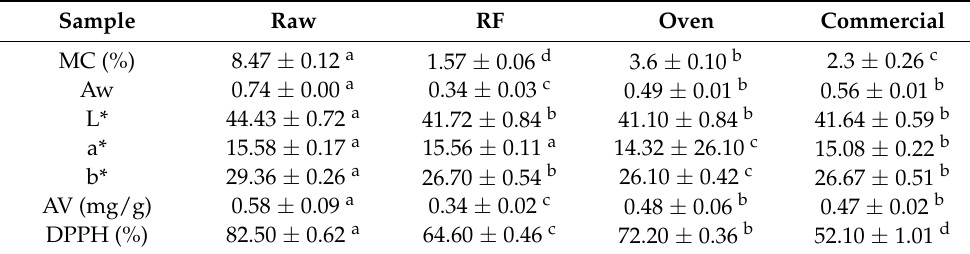
Table 1. Quality parameters of raw, RF-roasted, conventional-oven-roasted, and commercial almonds.